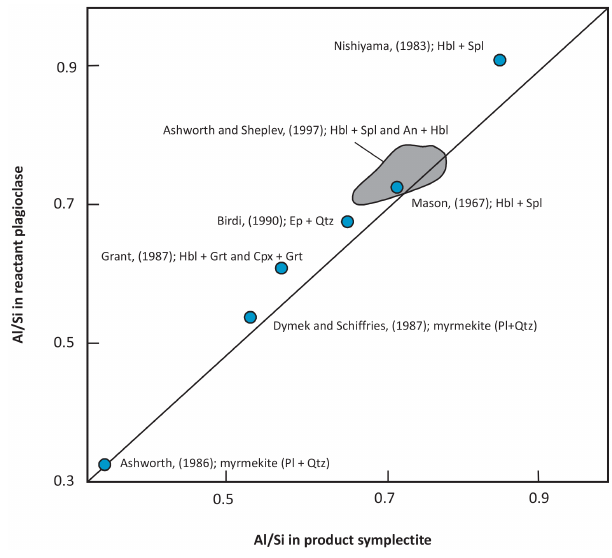
Figure 14. Isocon plot of Al / Si ratios in symplectites and the ad- jacent reactant plagioclase. The isocon line represents Al / Si ratios that are preserved exactly between reactant and products. Any de- viation from this line indicates a degree of open-system behaviour. In general, analysed symplectites from the literature plot above the isocon line, suggesting that the Al / Si ratio is lower in the product symplectite than it is in the reactant plagioclase; i.e. the corona sys- tem is losing Al to the external system relative to Si with prolonged